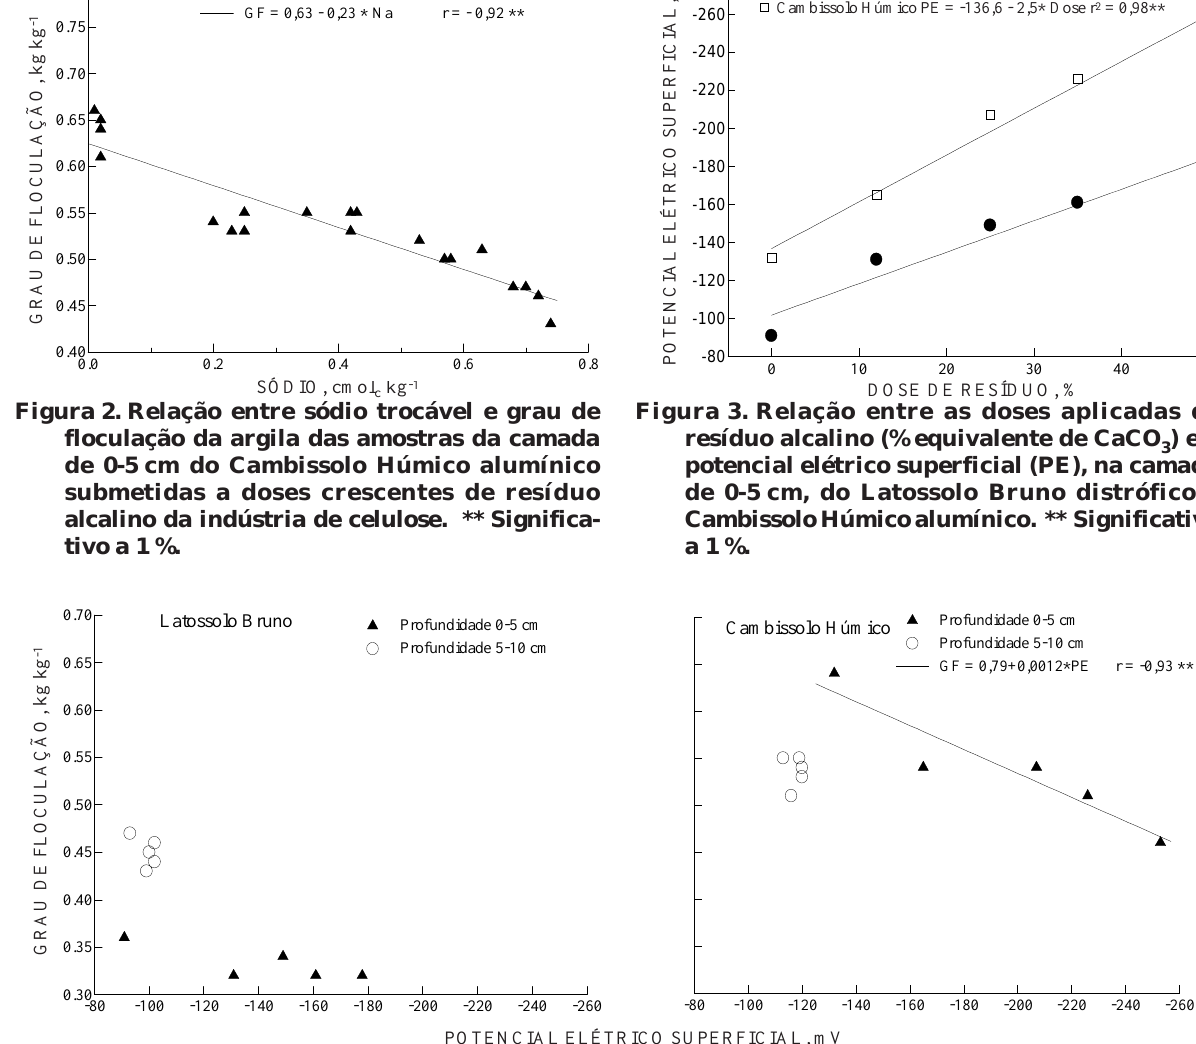
Figura 4. Relação entre o potencial elétrico superficial (PE, mV) e o grau de floculação da argila do Latossolo Bruno distrófico e do Cambissolo Húmico alumínico submetidos a doses crescentes de resíduo alcalino da indústria de celulose. ** Significativo a 1 %.